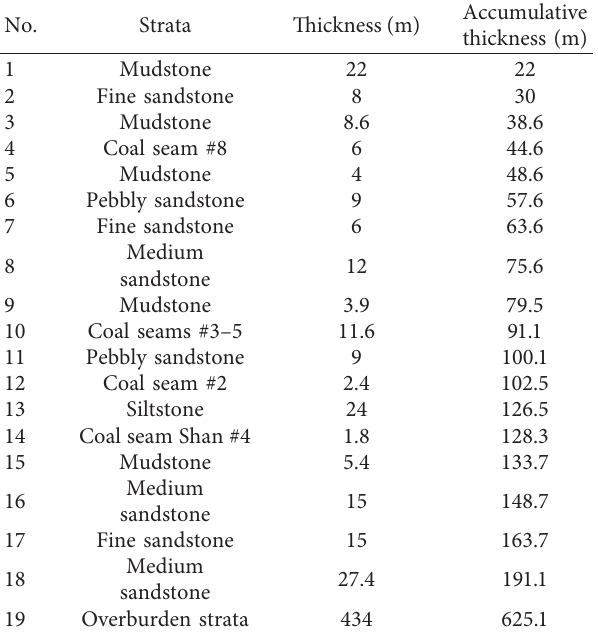
Figure 3: Diagram of the calculation of fractal dimension in the section plane: (a) model with fracture network and section plane; (b) the intersection of fracture network in the section plane; (c) calculation of fractal dimension using the “counting the box” method. Table 1: Detailed introduction of the rock types and thicknesses of the 8212 working face